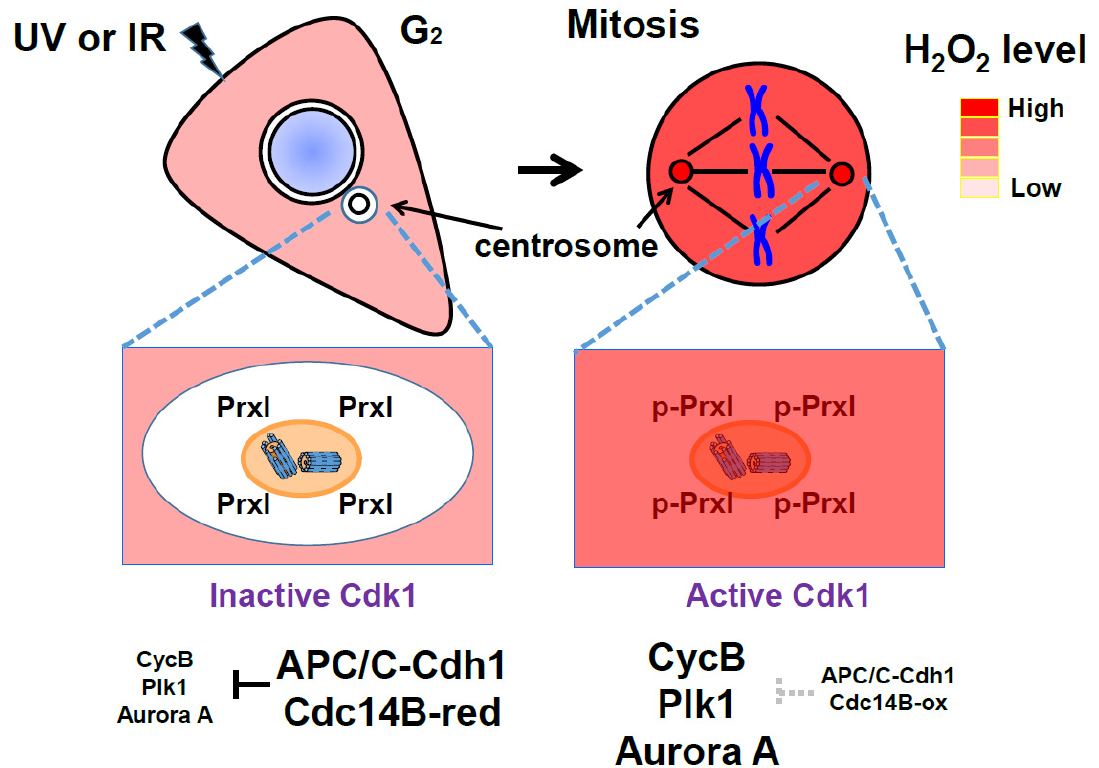
Figure 4. Protective role of peroxiredoxin I (PrxI) in the cell under oxidative stress: Centrosome-associated PrxI proteins shield the organelles from a high tide of H 2 O 2 molecules from various intracellular sources at G 2 phase. Anaphase-promoting complex/cyclosome (APC/C)–Cdh1 activity is high at the centrosome, and therefore, its substrates such as cyclin B, polo-like kinase1 (Plk1), and Aurora A are degraded. During mitosis, PrxI is inactivated by cell cycle-dependent kinase 1 (Cdk1) through phosphorylation and the large numbers of H 2 O 2 molecules inhibit APC/C-Cdh1, which results in increased cyclin B, Plk1, and Aurora A proteins. Centrosome-associated PrxI can protect cells from other oxidative stress, including ultraviolet (UV) or ionizing radiation (IR).